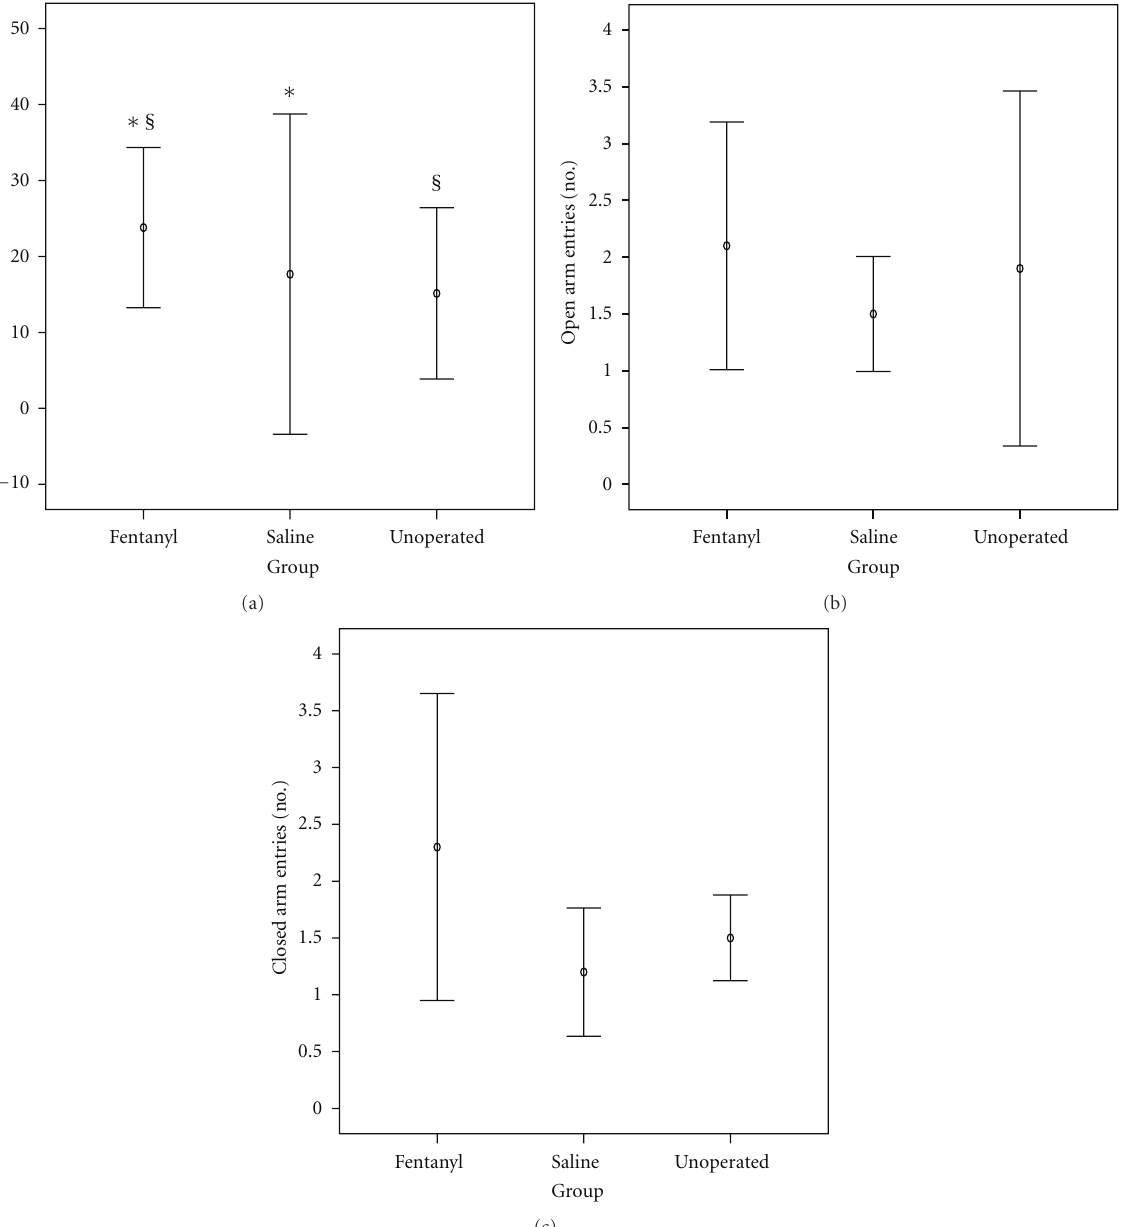
Figure 6: Performance in the elevated plus maze: (a) percent time in the open arms was significantly increased in fentanyl rats compared to saline rats ( ∗ P = 0 . 034) or unoperated controls ( § P = 0 . 045), suggesting that neonatal fentanyl exposure reduces some measures of anxiety- like behavior on the elevated plus maze; (b) and (c) represent the number of open arm and the number of closed arm entries, respectively, showing no significant di ff erences between groups. Values represent mean and 95% confidence interval for